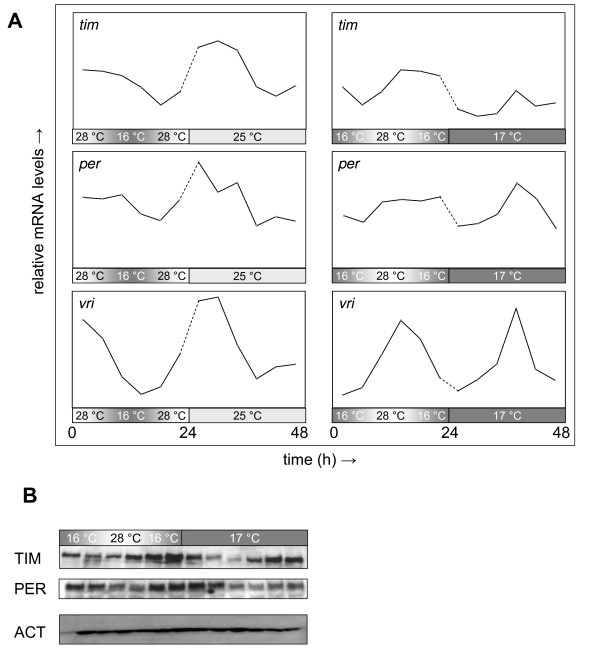
Clock gene expression rhythms during and after entrainment to daily temperature gradients. Canton-S flies were synchronized to a temperature gradient (16°C to 28°C) in constant darkness and then, during the experimental day, either kept in the temperature gradient or released to constant conditions at 25°C or 17°C. Fly heads were harvested 1, 5, 9, 13, 17, and 21 h after (subjective) peak temperature. Northern blot analyses for the clock-controlled transcripts tim, per, and vri (normalized to rp49 as an internal control) are represented in panel (A). For comparison the entrainment data set was plotted along with each of the two free run data sets in matching phase order. Each data point was the average of one to three independent experiments. Note that the entrained molecular phases were preserved during free run at either temperature, but that tim transcript levels appear to be down-regulated at constant 17°C. Western blot analysis for TIM, PER and ACTIN (as an internal control) of protein extracts from heads collected in the same schedule during entrainment and free run at constant 17°C (panel (B)) indicated that PER and TIM protein phases maintained a normal delay (~6 h) relative to transcript levels both during entrainment to the daily temperature gradient and subsequent free run at constant 17°C. Data for a representative Western blot are shown (note that, due to a lower amount of sample, the signals for the first time point, are artificially low).